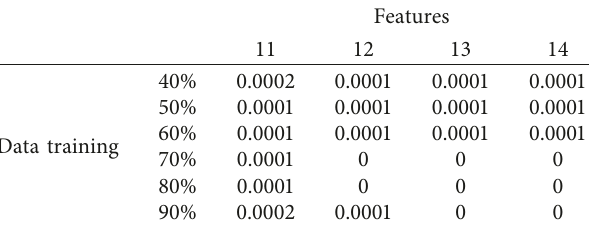
Table 5: PSO-SVR NMSE values of Bumi Serpong Damai Tbk